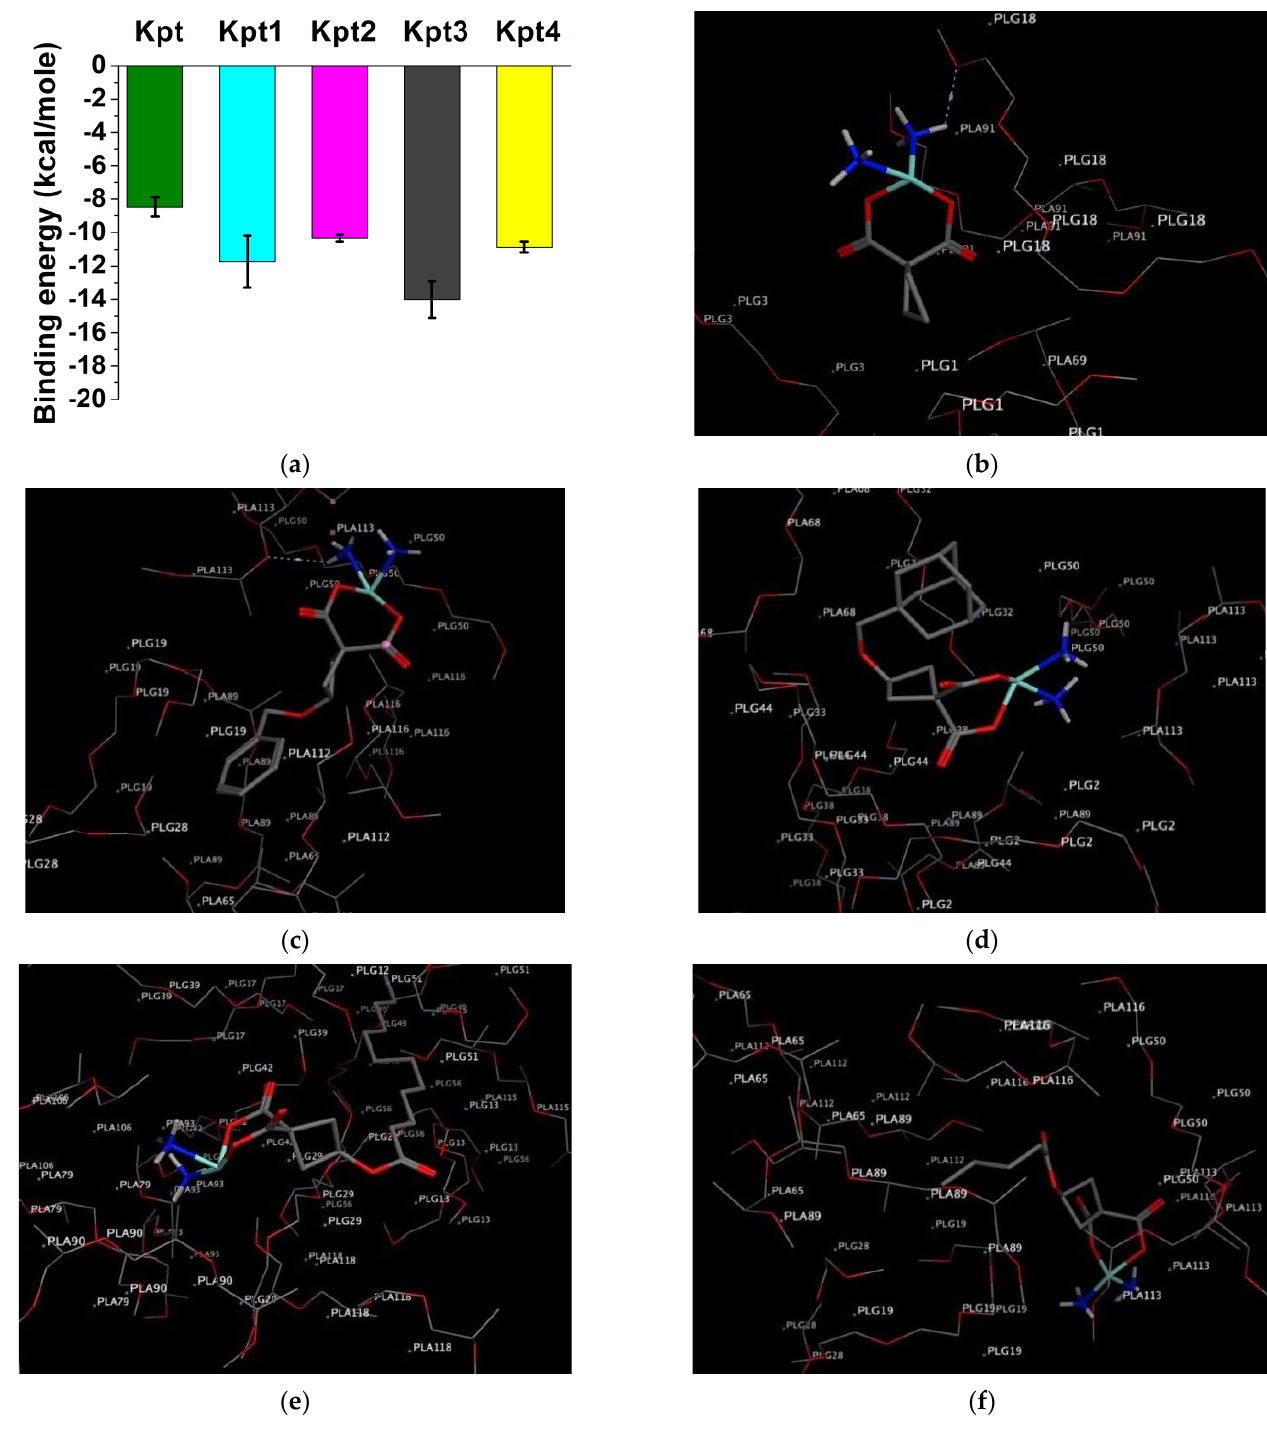
Figure 7. ( a ) Values of binding energy after drug docking on PLGA 50:50; 3D representation of the interaction of ( b ) Kpt, ( c ) Kpt1, ( d ) Kpt2, ( e ) Kpt3, and ( f ) Kpt4 with PLGA.